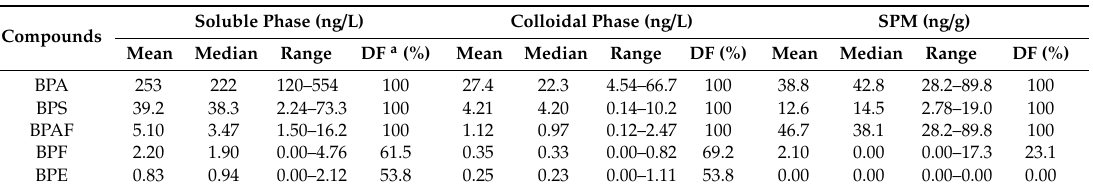
Table 1. Concentrations of bisphenol analogues detected in the suspended particulate matter, colloidal phases of surface water.